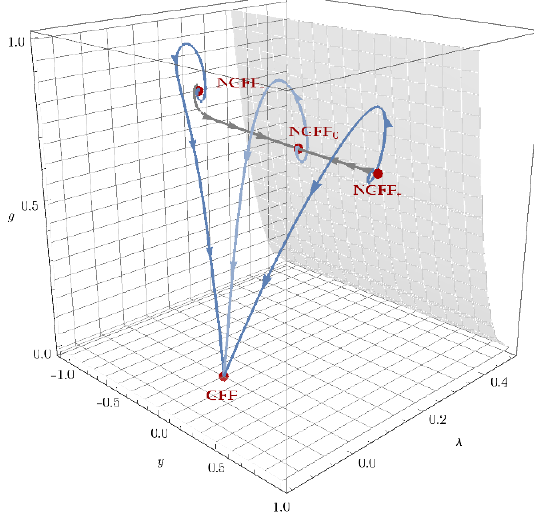
Figure 7 . Illustration of the phase diagram resulting from the beta functions (3.13) for N s = 1. The GFP and the three NGFPs are marked with red points while the singular loci y sing = (cid:0) 1 and (cid:17) sing are shaded in gray. The RG trajectories connecting the (cid:12)xed points are shown in blue (Type N IIa trajectories) and gray. All arrows point from UV to